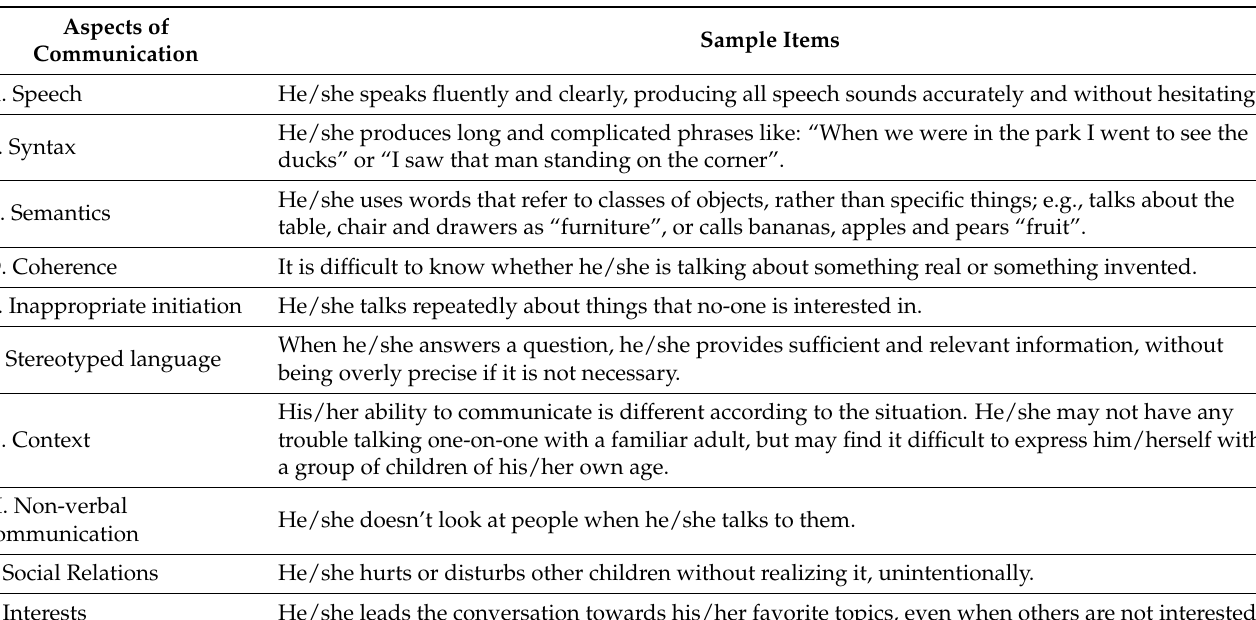
Table 1. Examples of items from the communication aspects measured in the Children’s Communication Checklist-2